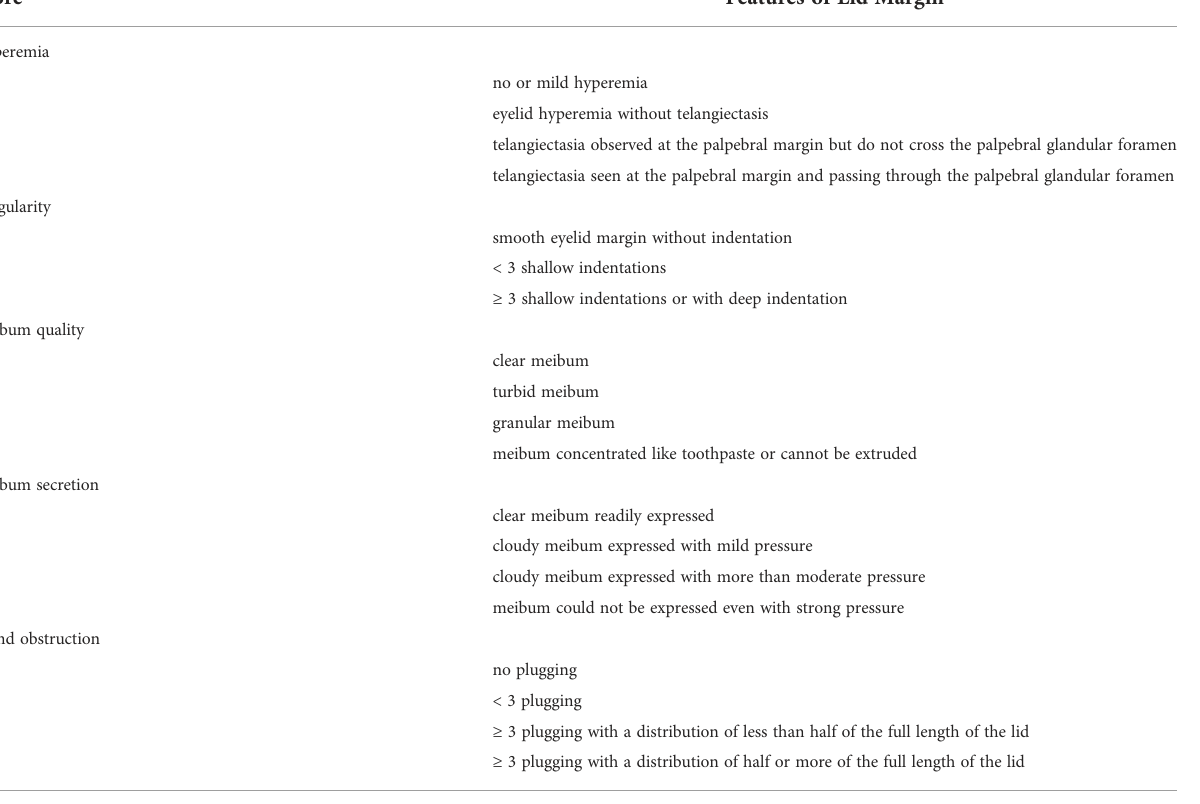
TABLE 1 Scales of lid margin